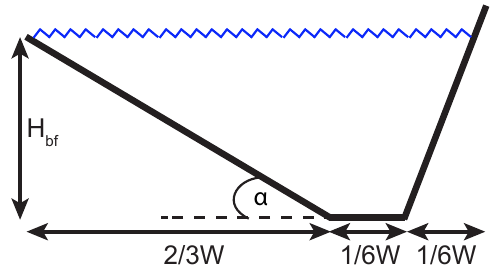
Figure 3. Sketch of the cross-sectional flow area of a meandering channel used for the bankfull palaeodischarge calculations (Allen, 1965; Hobo, 2015; Leeder, 1973). Huisink (2000, p. 123) (Fig. 2). Here we assumed a similar relative error of W , A , and P as was taken for H bf